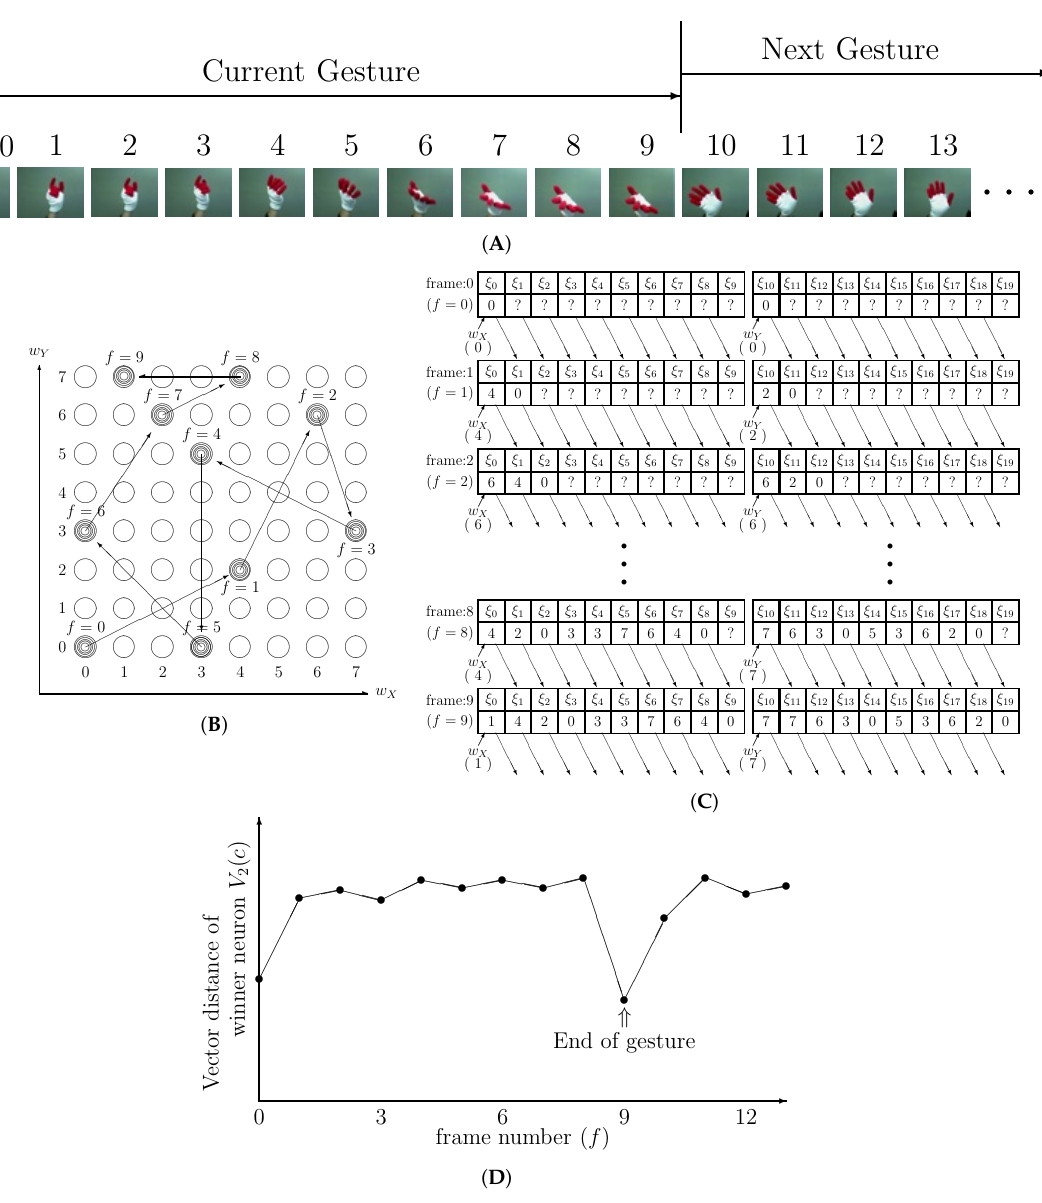
Figure 3. Example of operation of the proposed system, ( A ) Input gesture frames, ( B ) Winner neurons in the SOM-1, ( C ) Development of the shift registers, ( D ) Vector distance V ( c ) of winner neurons in the SOM-2.